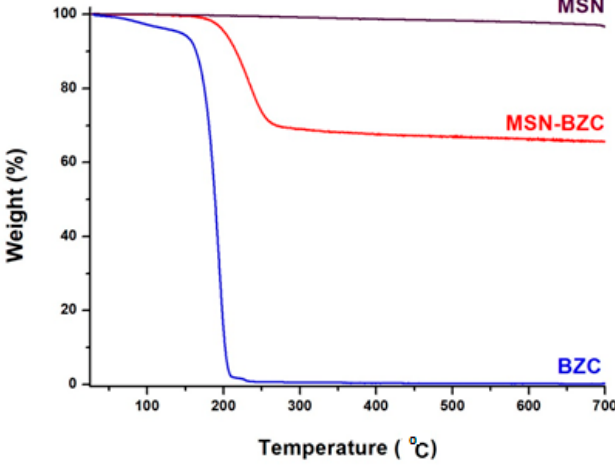
Figure 3. Thermogravimetric analysis (TGA) curves for MSN, BZC and MSN modified with BZC.